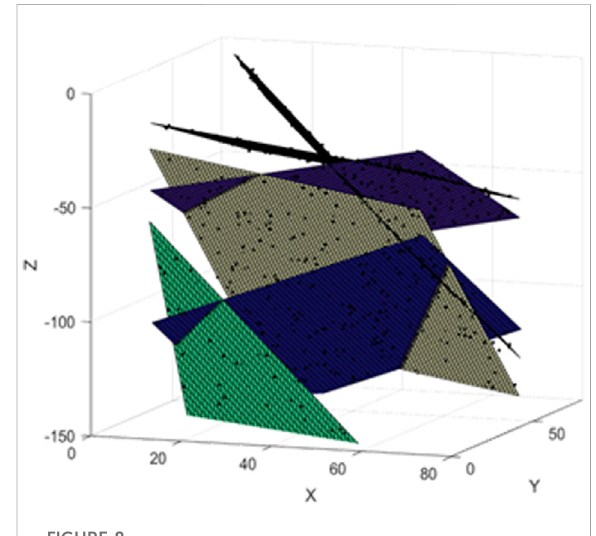
FIGURE 8 Result of fracture modeling using orientation data. The number and orientation of the planes were almost identical to those of the true model shown in Figure 3A.